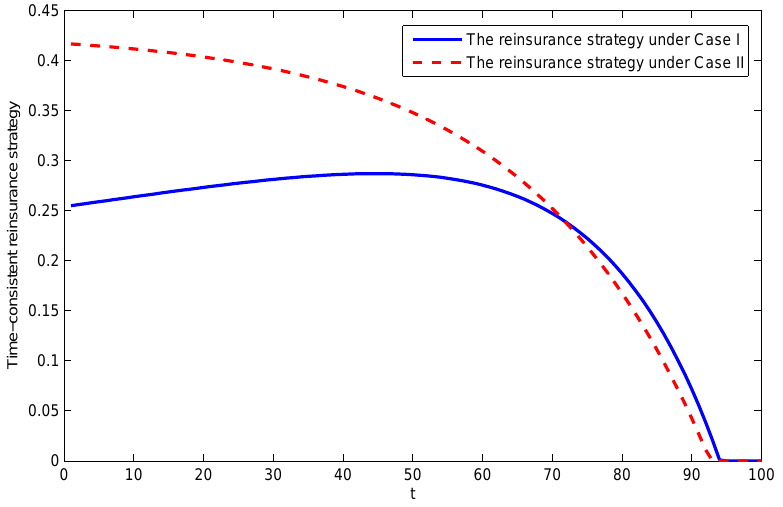
Figure 3. Time-consistent reinsurance strategy under the expected value principle ( α = 0.4 and T = 100).